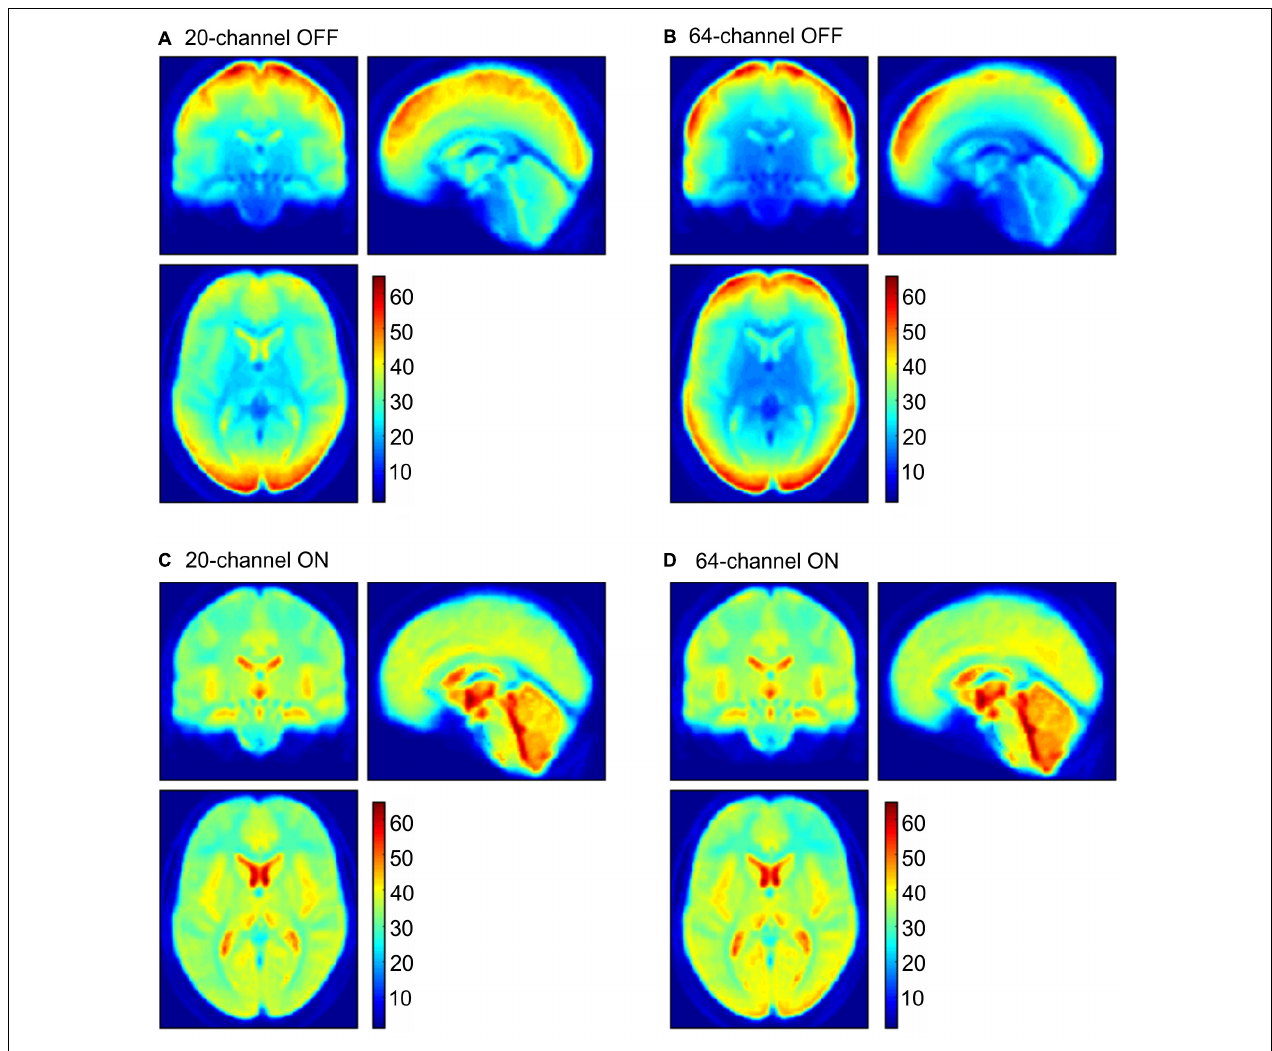
FIGURE 6 | tSNR maps for the 20-channel head coil ( A,C left column) and the 64-channel head coil ( B,D right column) with the prescan normalize filter OFF ( A,B upper row) and ON ( C,D lower row). tSNR, time-course signal-to-noise